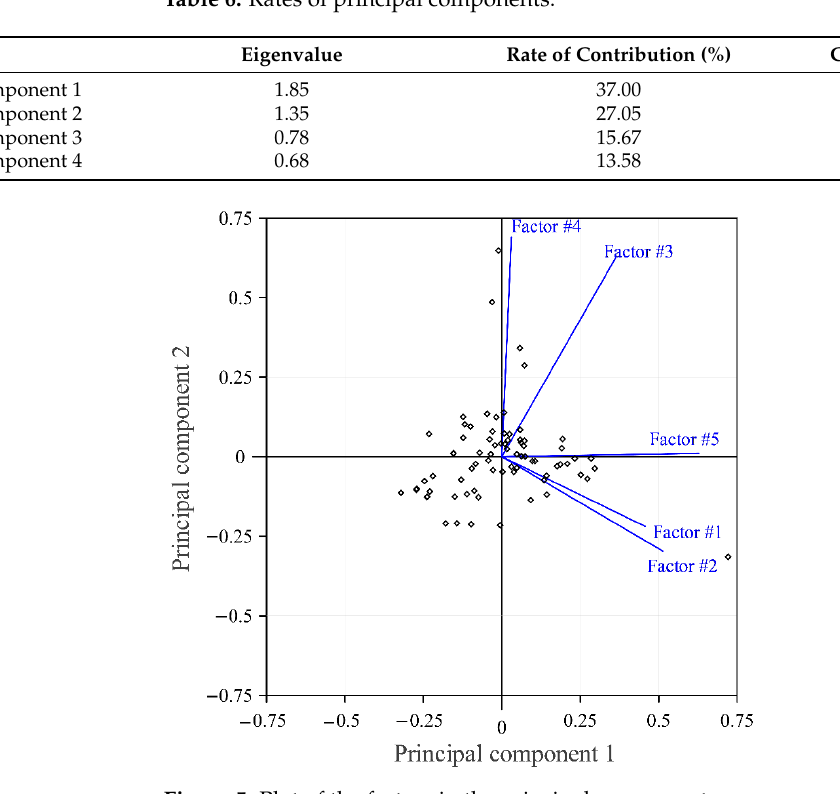
Table 6. Rates of principal components.